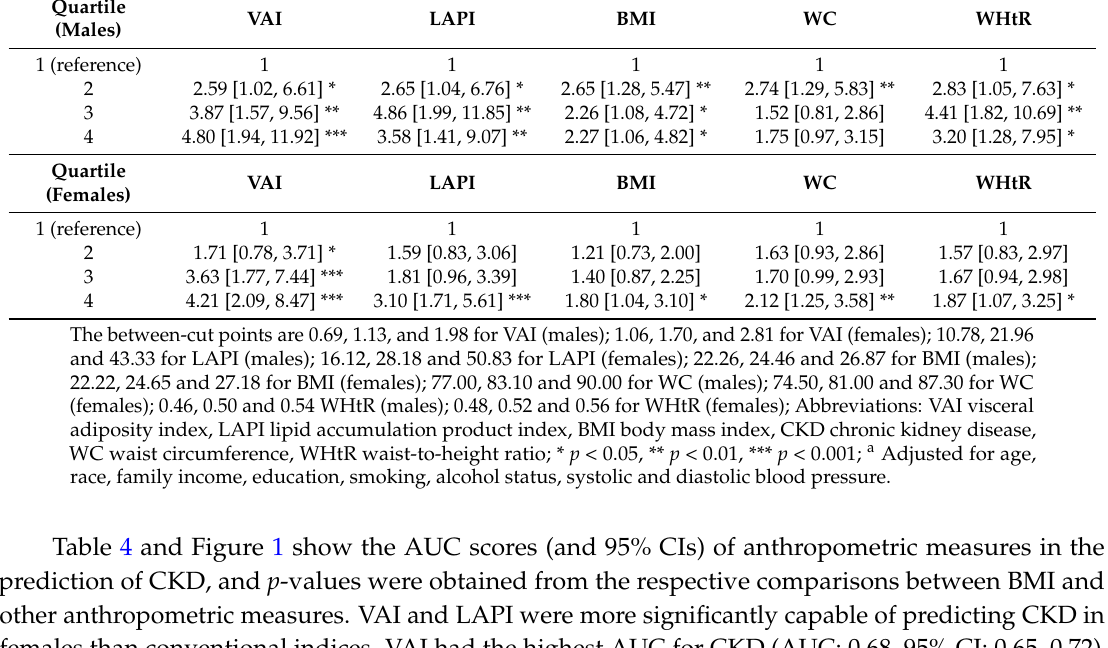
Table 3. Odds ratio (95% CI) of the presence of CKD for each anthropometric measure a . Quartile VAI LAPI BMI WC WHtR (Males)